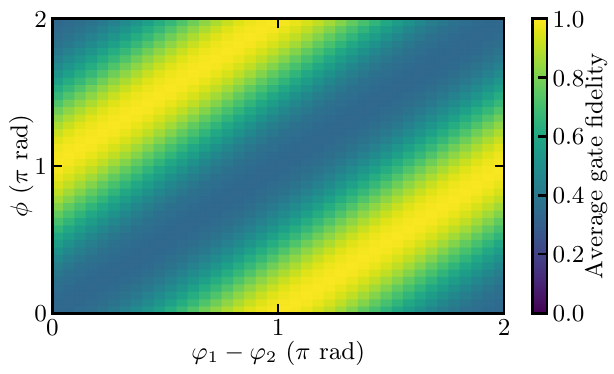
FIG. 11. Calibrating the CCZS (π/ 2, φ , 0 ) gate by tuning the phase difference ϕ 1 − ϕ 2 between the signals modulating the two tunable couplers. The simulations are performed using three energy levels per qubit. The plots shows the gate fidelity for the CCZS (π/ 2, φ , 0 ) gate as a function of φ and ϕ 1 − ϕ 2 . All other parameters are the same as those that gave the highest gate fidelity for CCZS (π/ 2, π , 0 ) in Fig. 10. For each value of φ shown in the plot, the highest gate fidelity exceeds